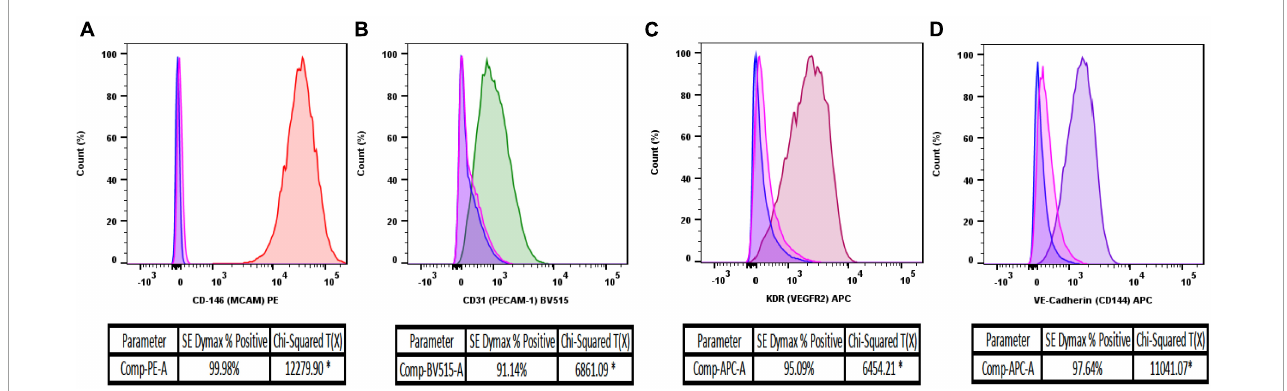
FIGURE3 Flow cytometry analysis of isolated MRPEC monocultures 10 days post-isolation. Representative flow cytometry histograms of MRPEC monocultures 10 days post-isolation. (A) CD146-PE+ (red) MRPECs vs. IgG-PE+ isotype (pink) and unstained (blue) controls, (B) CD31-BV515+ (green) MRPECs vs. IgG-BV515+ isotype (pink) and unstained (blue) controls, (C) KDR (VEGFR2)-APC+ (burgundy) MRPECs vs. IgG-APC+ isotype (pink) and unstained (blue) controls, (D) VE-cadherin-APC+ (purple) MRPECs vs. IgG-APC+ isotype (pink) and unstained (blue) controls. *Chi-squared T(x) values ≥ 4 are considered statistically significant. N = 4–12 mice/marker.